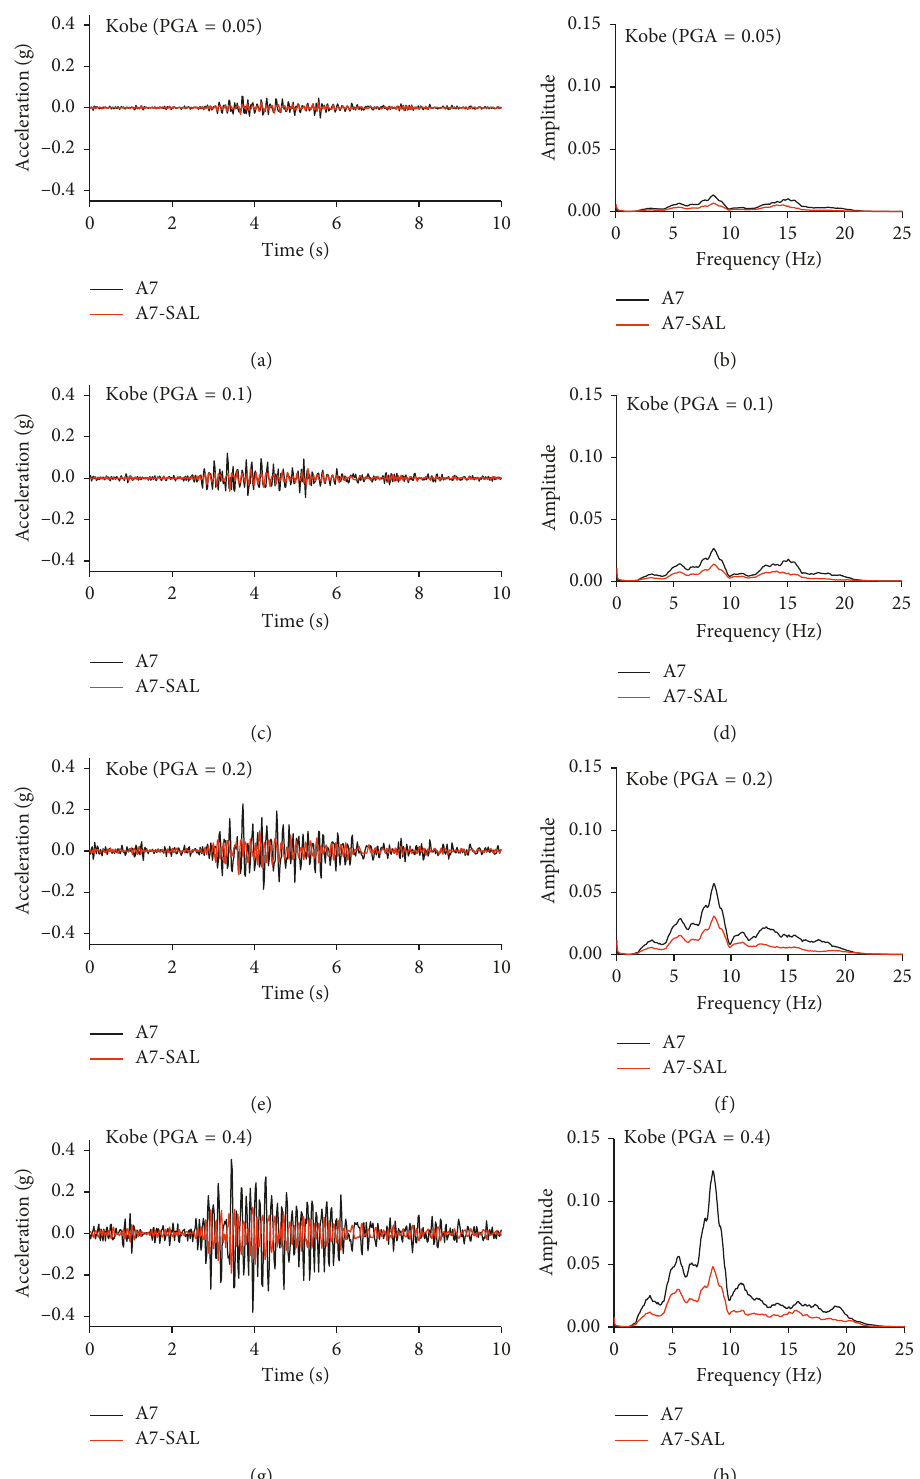
0.05g. (c) and (d) Peak acceleration (cid:31) (cid:31)